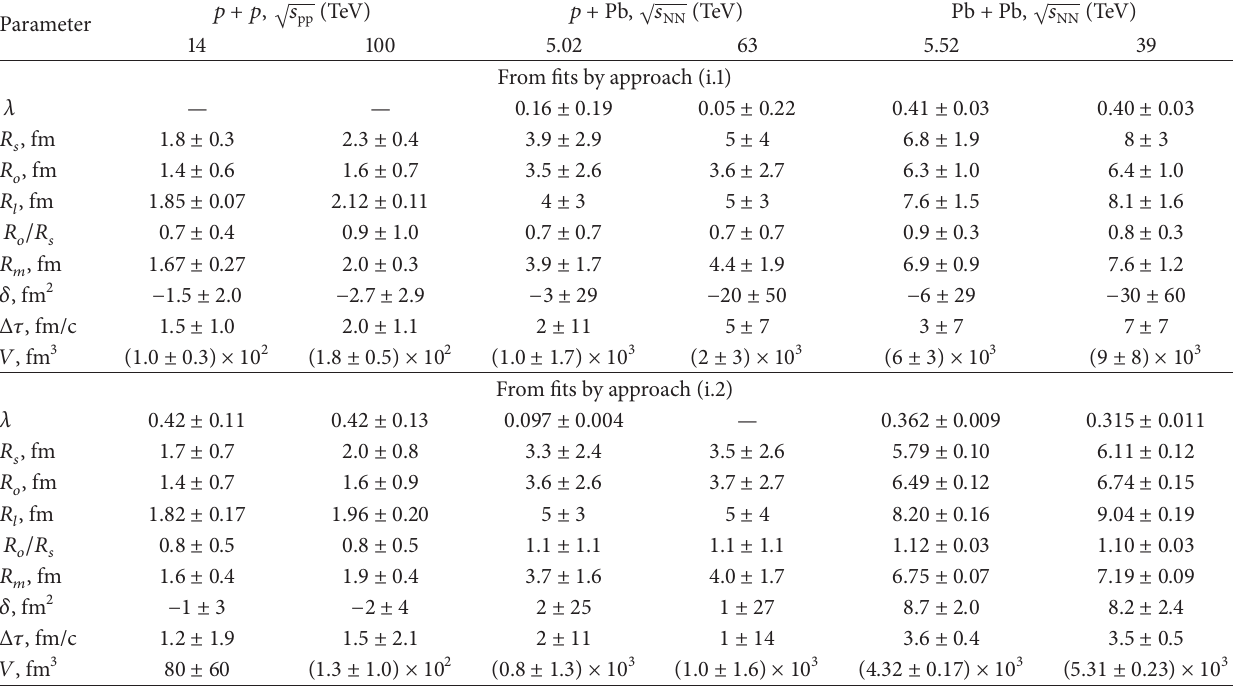
Table 2: Estimations for space-time characteristic of pion source at the LHC and FCC energies.